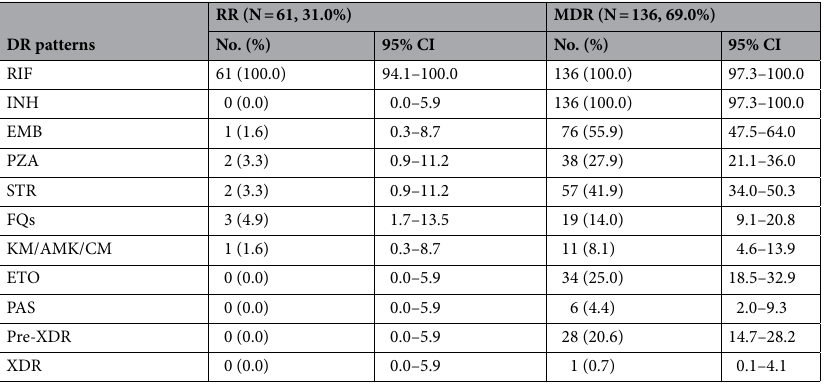
Table 2. Phenotypic drug resistance patterns of 197 RR and MDR/Pre-XDR/XDR Mycobacterium tuberculosis isolates. Excluding 2 isolates with disputed rpoB mutations and 1 streptomycin mono-resistant isolate.